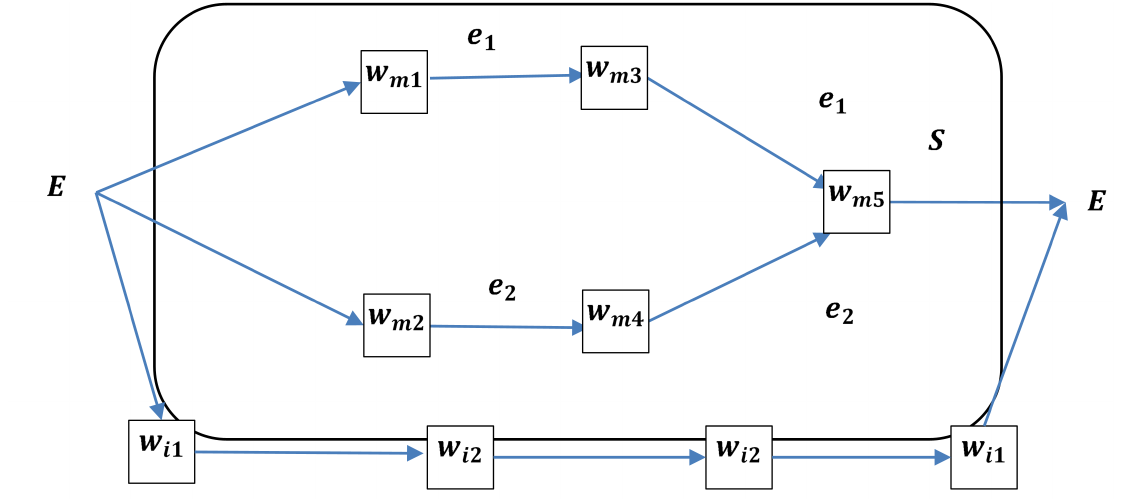
Figure 2. The example of information and noninformation technological routes of a complex technical